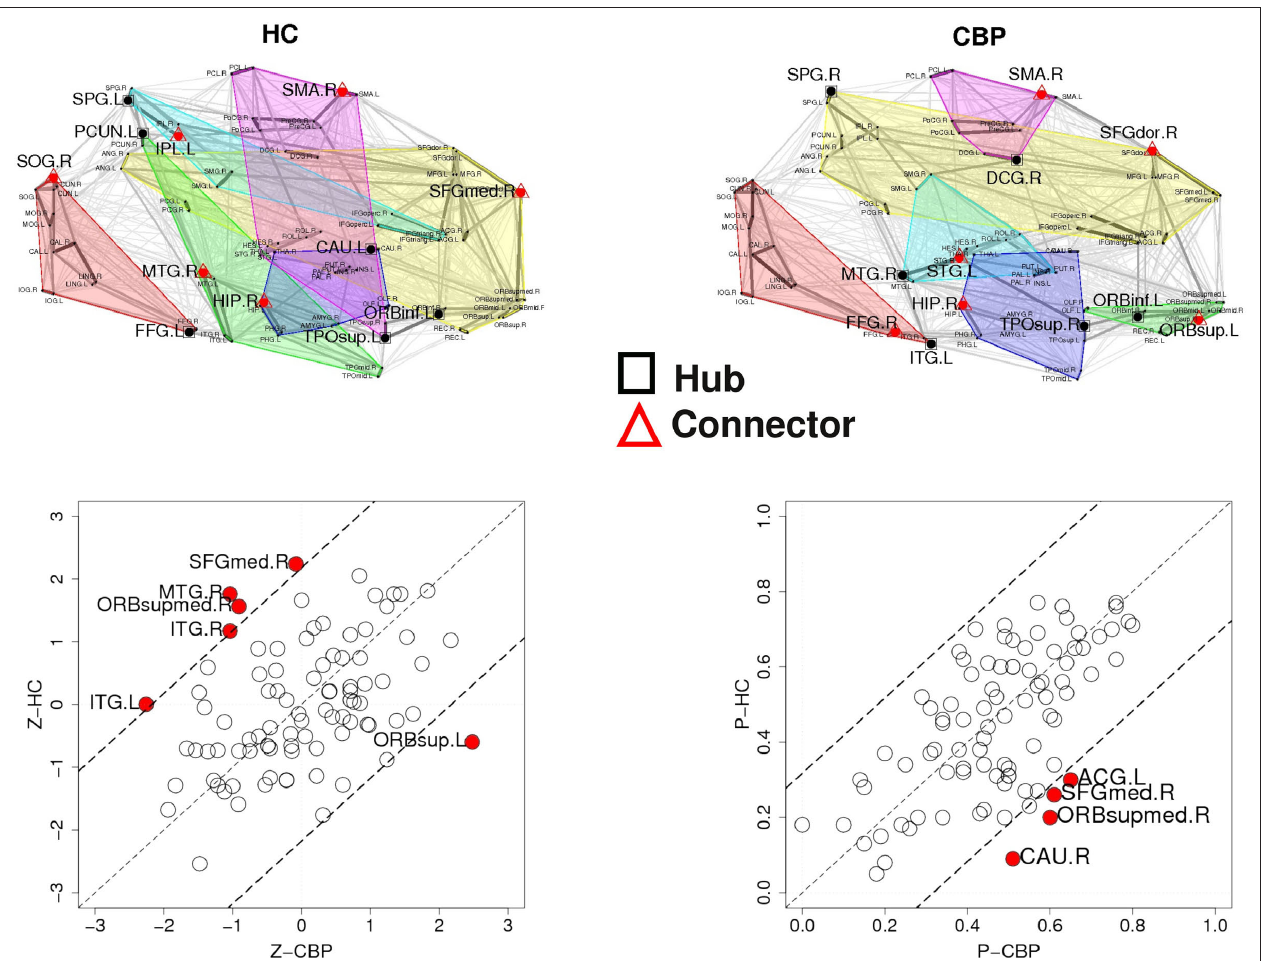
Figure 6 | Top panels: Hubs (nodes with highest intra-modular degree) and connectors (highest participation coefficient) in each module for both group networks. Bottom panels: Left: z i ,( )HC versus z i ,( )CBP , right P i ,( )HC versus P . The regions which display a role’s change larger than two standard deviations (dashed i ,( )CBP lines) are labeled and plotted using filled